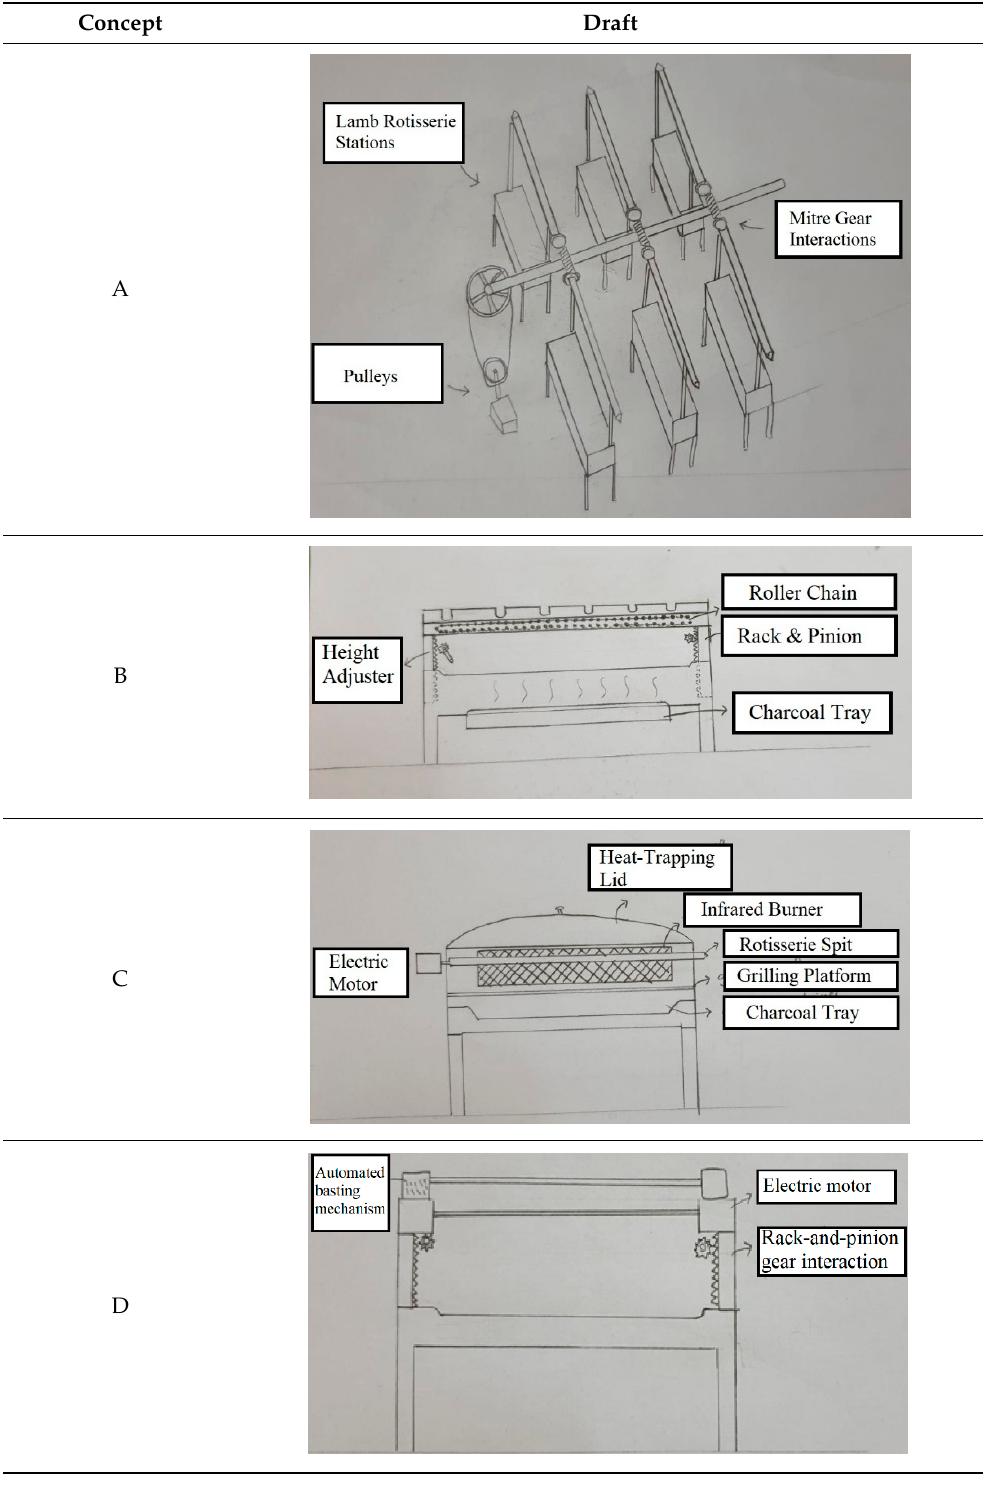
Table 6. Draft of the concepts.